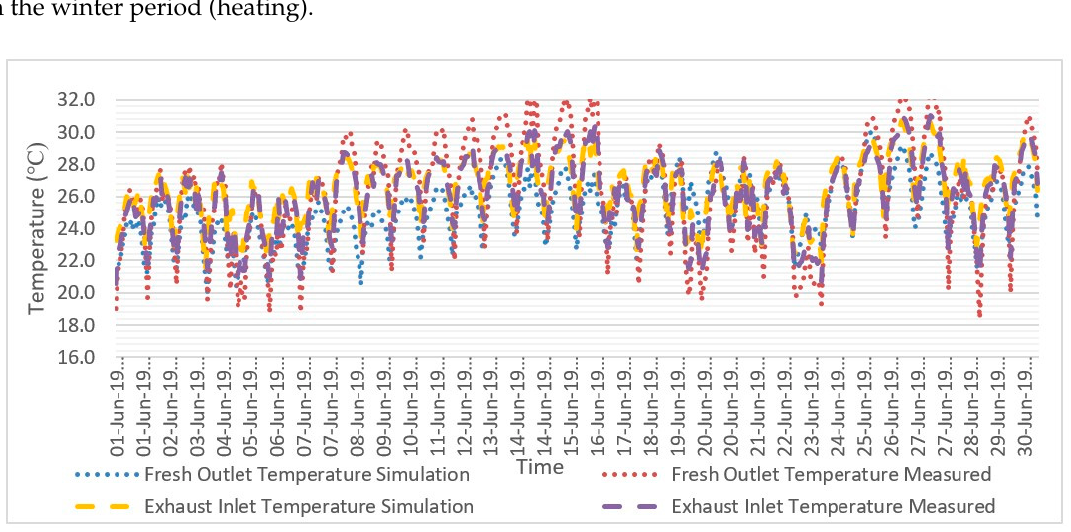
Figure 5. The fresh outlet and exhaust inlet around the heat during summer.